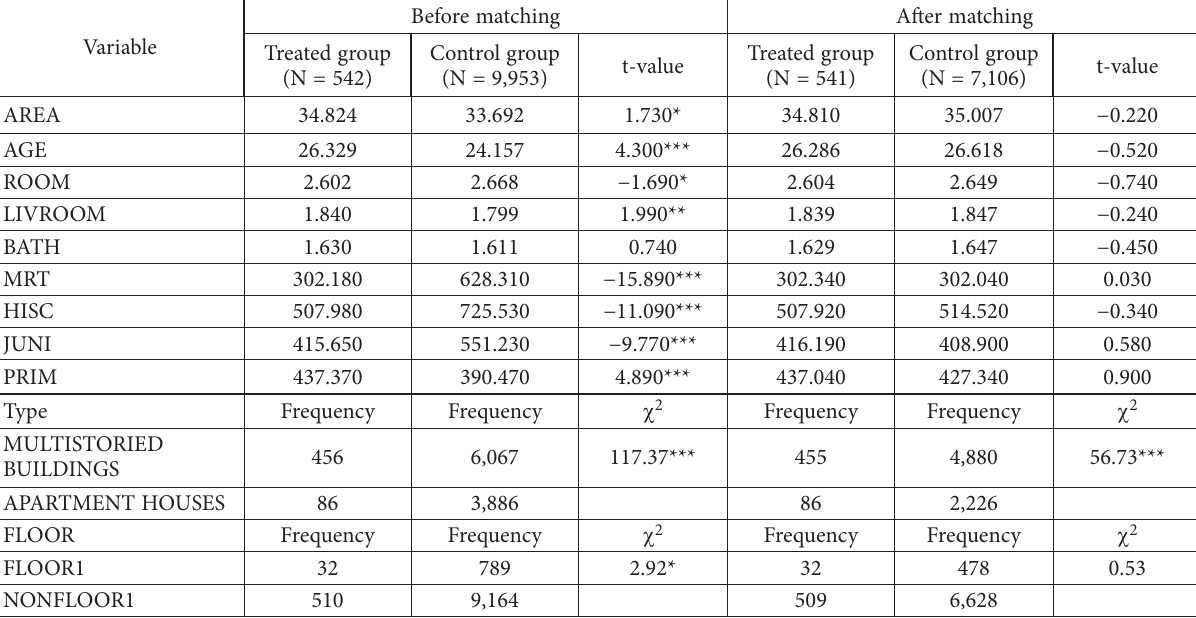
Table 3. Differences in mean values between the experimental group and the control group after construction Before matching After Variable